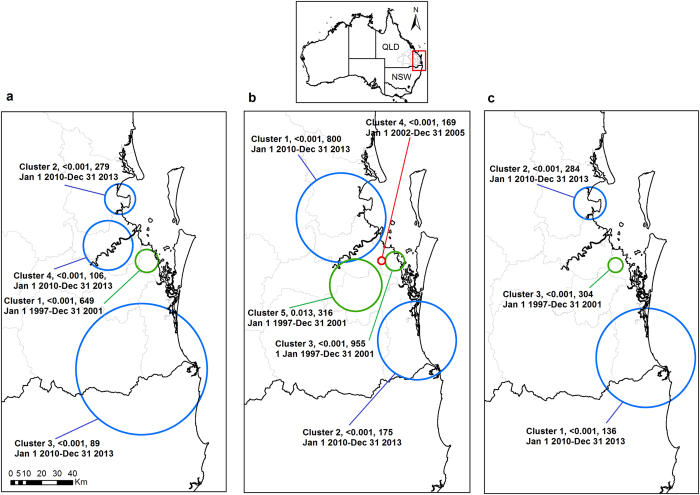
Locations of significant clusters of aetiologies as determined by the space-time permutation scans.(a–c) The area comprised within the rectangle includes the South East Queensland study area for the space-time permutation. The following map inserts display the significant clusters by the space-time permutation scans: (a) trauma by motor vehicle, (b) Chlamydia-like signs, (c) wasting. Each cluster is labelled with its p-value, number of observations, and time frame. Maps generated using ESRI ArcGIS Desktop v10.2.158. Centre points for each cluster generated using SaTScanTM v8.056. SaTScanTM is a trademark of Martin Kulldorff. The SaTScanTM software was developed under the joint auspices of (i) Martin Kulldorff, (ii) the National Cancer Institute, and (iii) Farzad Mostashari of the New York City Department of Health and Mental Hygiene.